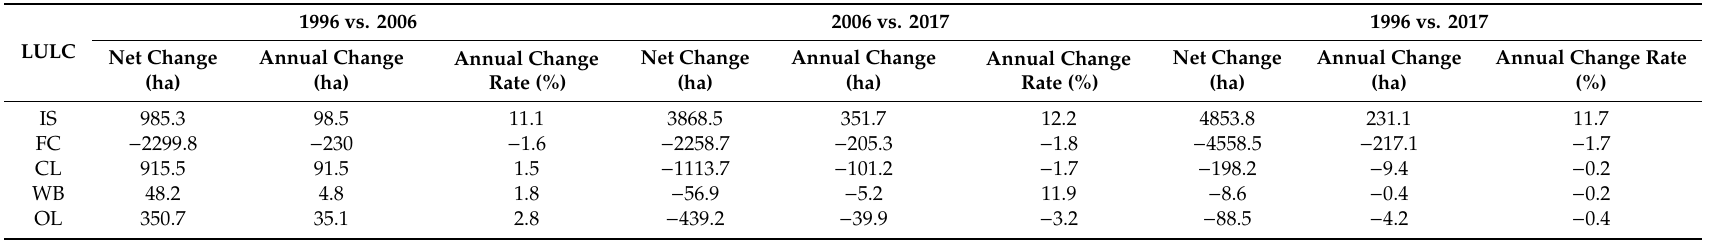
Table 6. LULC change